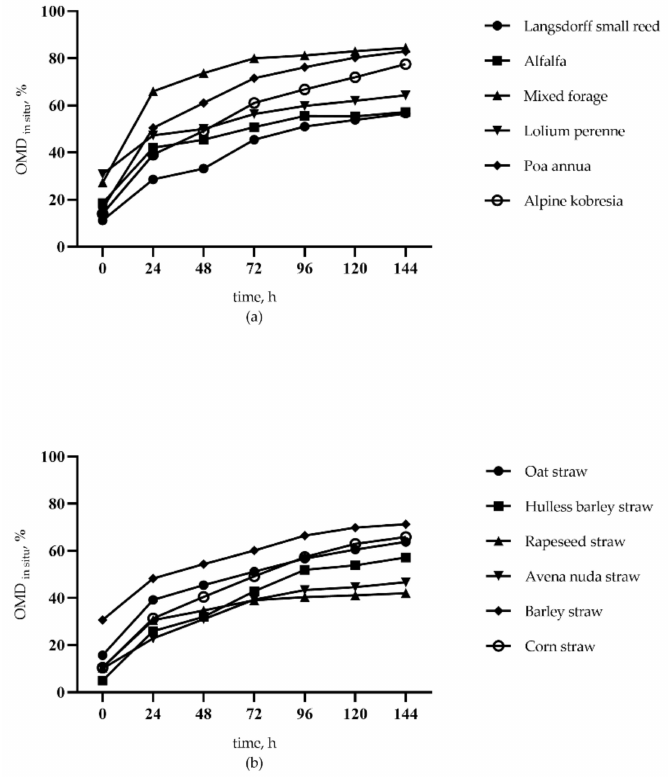
Figure 1. Incubated time (x) and in situ organic matter disappearance rate (y) of forages ( a ) and crop residues ( b ), respectively.